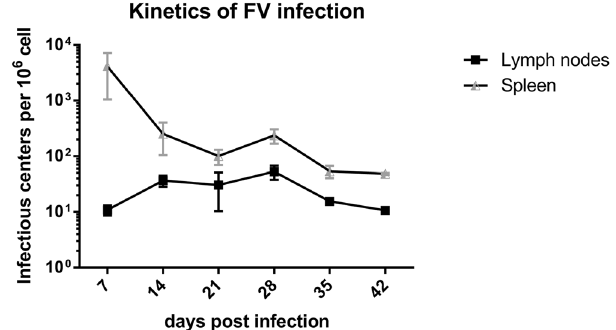
Figure 1. Kinetics of FV infection. Viral loads of FV-infected C57BL/6 mice were analyzed in spleens and lymph nodes using an infectious center assay. At least six mice per group were analyzed. Data were pooled from two independent